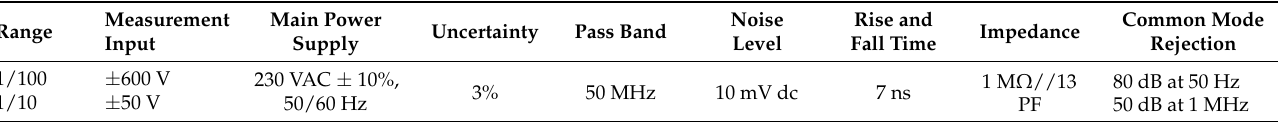
Table 3. Electrical characteristics of the MTX differential